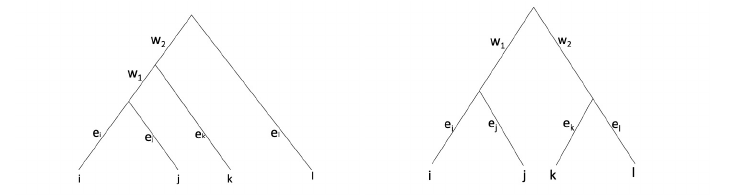
Figure 4. Two cases for equidistant trees without